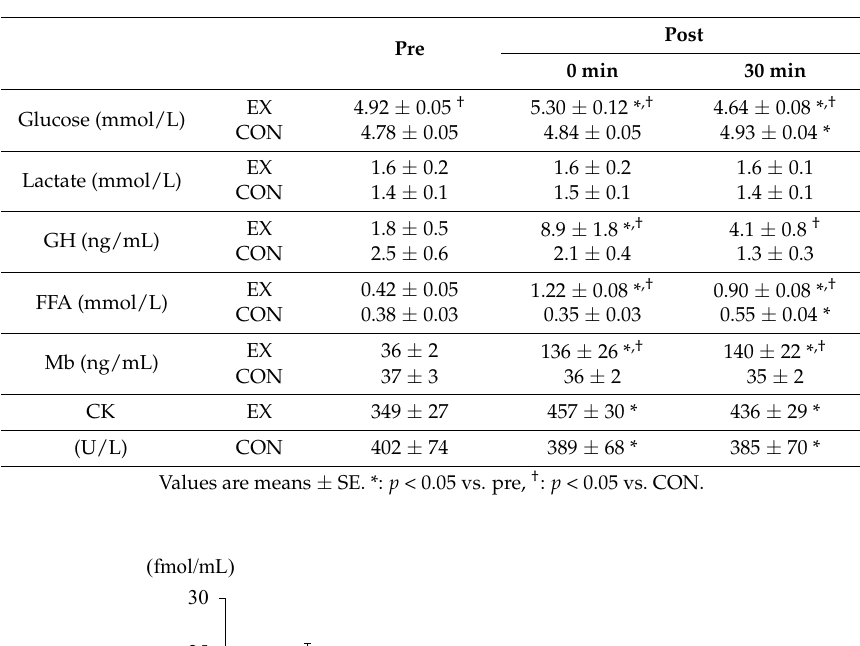
Table 2. Change in blood variables.